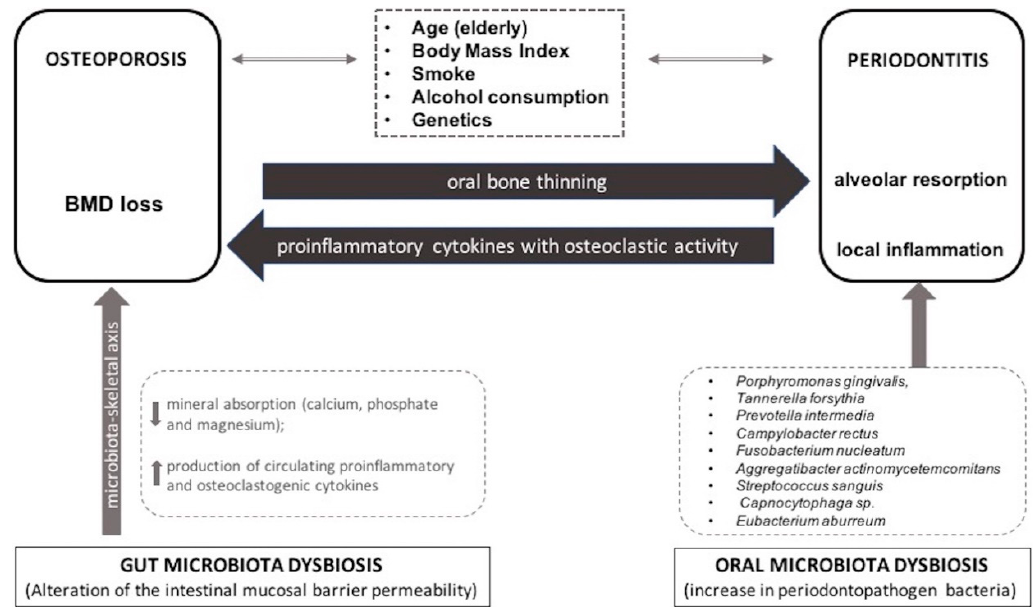
Figure 1. The bidirectional interrelationships between osteoporosis (OP) and periodontitis (PD). They share a series of common risk factors. The bone mineral density (BMD) loss associated with OP may be responsible for increasing the alveolar bone resorption in PD, and, conversely, the local inflammation peculiar of PD may activate systemic osteoclastic cytokines responsible for further BMD decrease. In this scenario, the role of gut and oral dysbiosis may enhance and / or trigger these events, leading towards a worsening of both pathologies and the healthy state of the affected subjects. BMD, Bone Mineral Density.